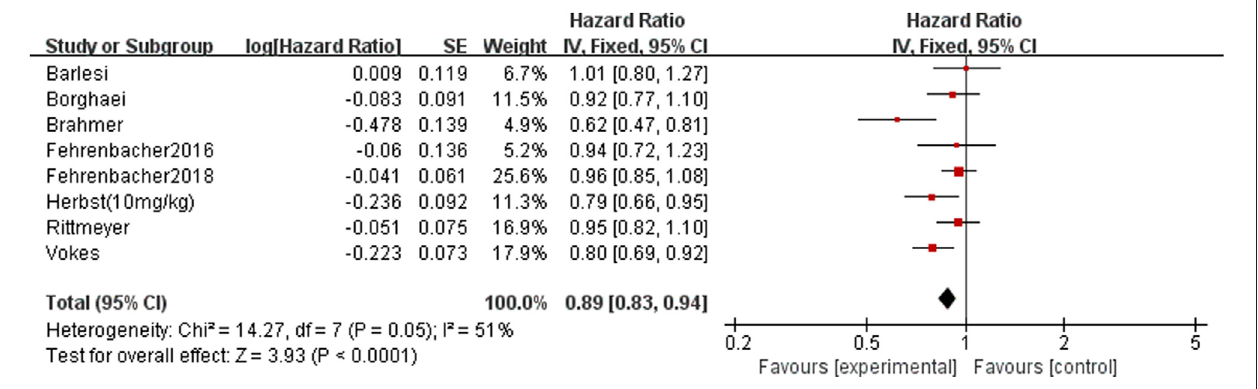
FIGURE 5 | Comparison of progression-free survival between groups.